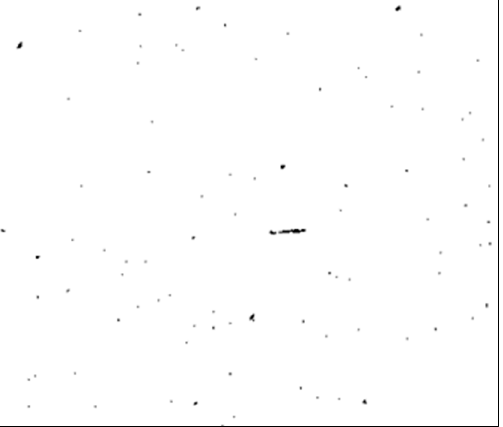
Figure 8. Binary image, following thresholding of the movement image.